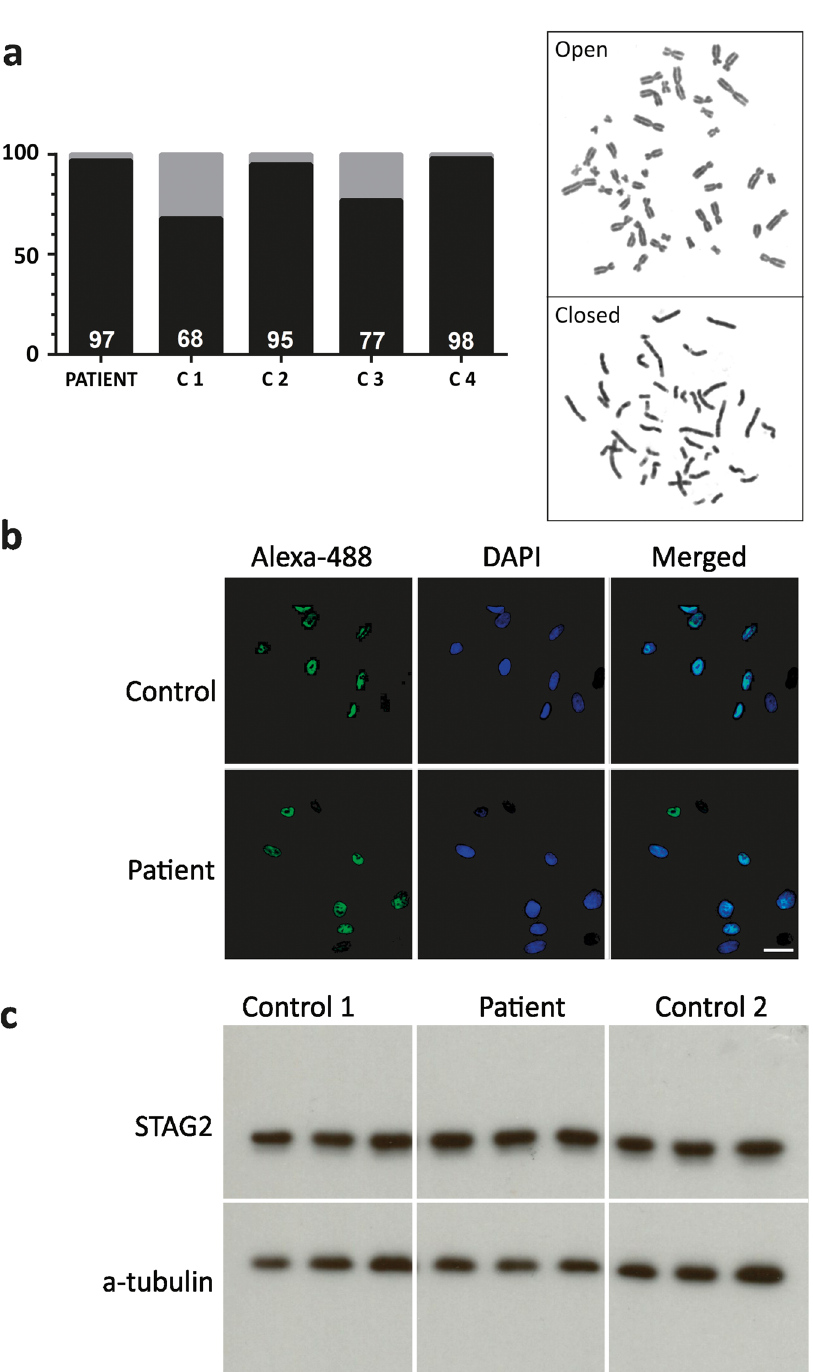
Fig. 2 Sister chromatid cohesion assay and immunoreaction experiments. a p.Ser327Asn STAG2 does not show effect on the sister chromatid phenotype. Open ( gray ) and closed ( black ) sister chromatids are shown for the patient and four controls with WT STAG2 (C1-4). A total of 100 metaphases were analyzed for each individual. The amount of closed sister chromatids are indicated at the bottom of each individual column. Open and closed sister chromatid phenotypes in metaphase cells from the patient are demonstrated. b Immuno fl uorescence of patient fi broblasts. Cultured fi broblasts from the proband were incubated overnight with anti-STAG2 (J-12) at 4 °C followed by Alexa 488-conjugated second antibody ( green ) and nuclear counterstain with DAPI ( blue ). The nuclear localization of STAG2 was con fi rmed in the double label immuno fl uorescence merged picture. Similar results were observed in three independent experiments. c Western blot of STAG2 from patient fi broblasts. Protein extracts from patient and control individuals were subjected to immunoblotting using the anti-STAG2 (J-12). After visualization of STAG2, the blot membrane was stripped and re-probed with alpha-tubulin antibody, which was used as a quantitative control. Similar results were observed between the patient and the two controls in three independent